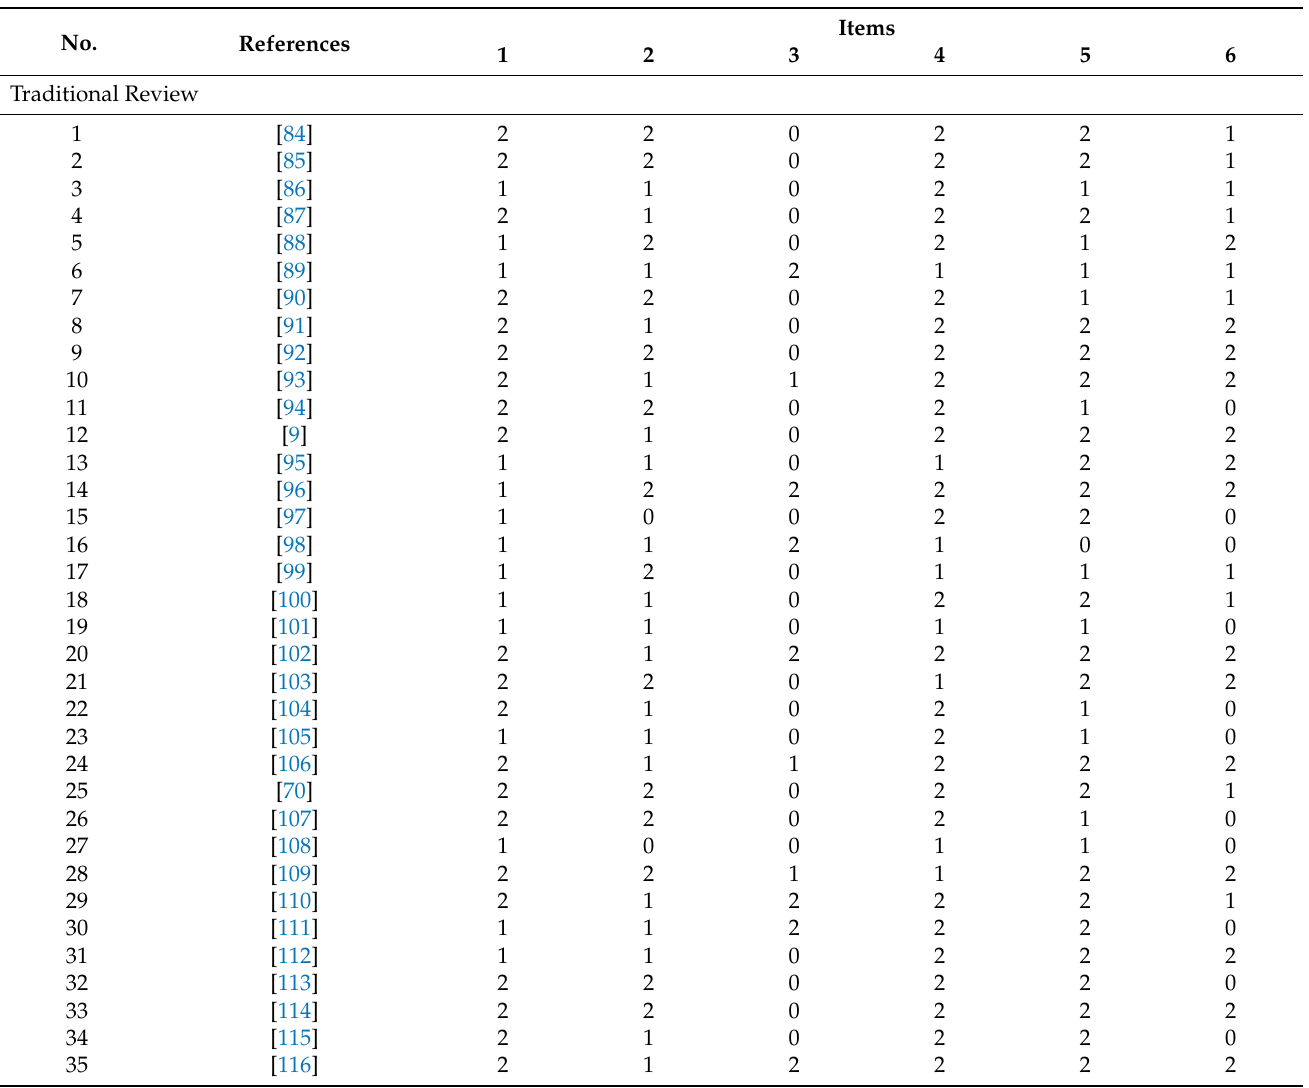
Table A3. SANRA rating for each included review work (non-systematic